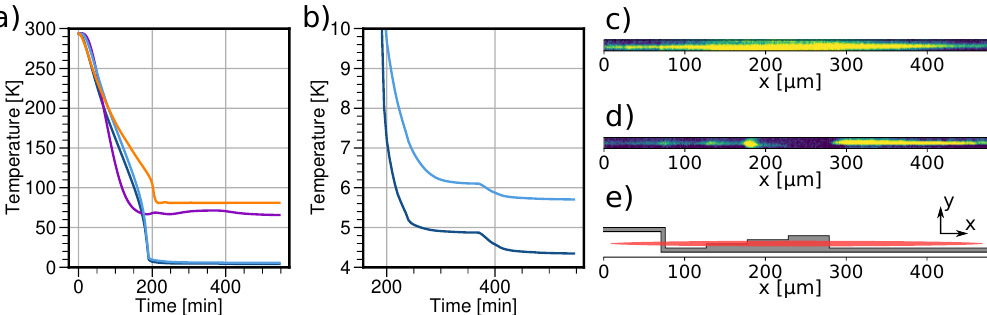
Figure 5: Typical cooling curve over (a) the full cool down period and (b) near base temperature. Temperatures are plotted for sensors labeled by triangles in Fig. 1: ULVI second stage (dark blue), sample mount (light blue), ULVI radiation shield (purple), and sample radiation shield (orange). The sensor on the sample substrate (not plot- ted) follows the sample mount (light blue) to within 1 K while cooling and less than 0.1 K when the temperature is stable. The liquid nitrogen-cooled radiation shield reaches a base temperature of 80 K in 4 hours, while the sample cools to 5.7 K over 8 hours. The downturns near 160 min and 200 min in the sample mount and radia- tion shield, respectively, are caused by a decrease in the specific heat of copper near 100 K [ 28 ] . The plateau and downturn in sample temperature near 370 min, as well as fluctuations in ULVI shield temperature from 150 min to 500 min, are caused by liquefaction of helium within the ULVI. (c,d) Absorption image of the atoms (yellow) trapped with the atom chip’s magnetic fields 1-2 µ m from a sample consisting of a patterned niobium superconductor. The Nb is cooled to (c) 9.3 K and (d) 9.0 K. These temperatures are above and below the superconducting transition temperature T , c respectively. The fragmentation of the gas below Nb’s T may be ascribed to the dis- c tortion of the magnetic trap due to the Meissner repulsion of magnetic field through the nearby superconductor. (e) Sketch of the Nb film. Niobium is shown in gray, with the atomic gas location roughly indicated in red. Distortions of the gas density shown in panel (d) roughly correspond to the abrupt changes in the Nb wire width, as would be expected from the stray fields produced from these